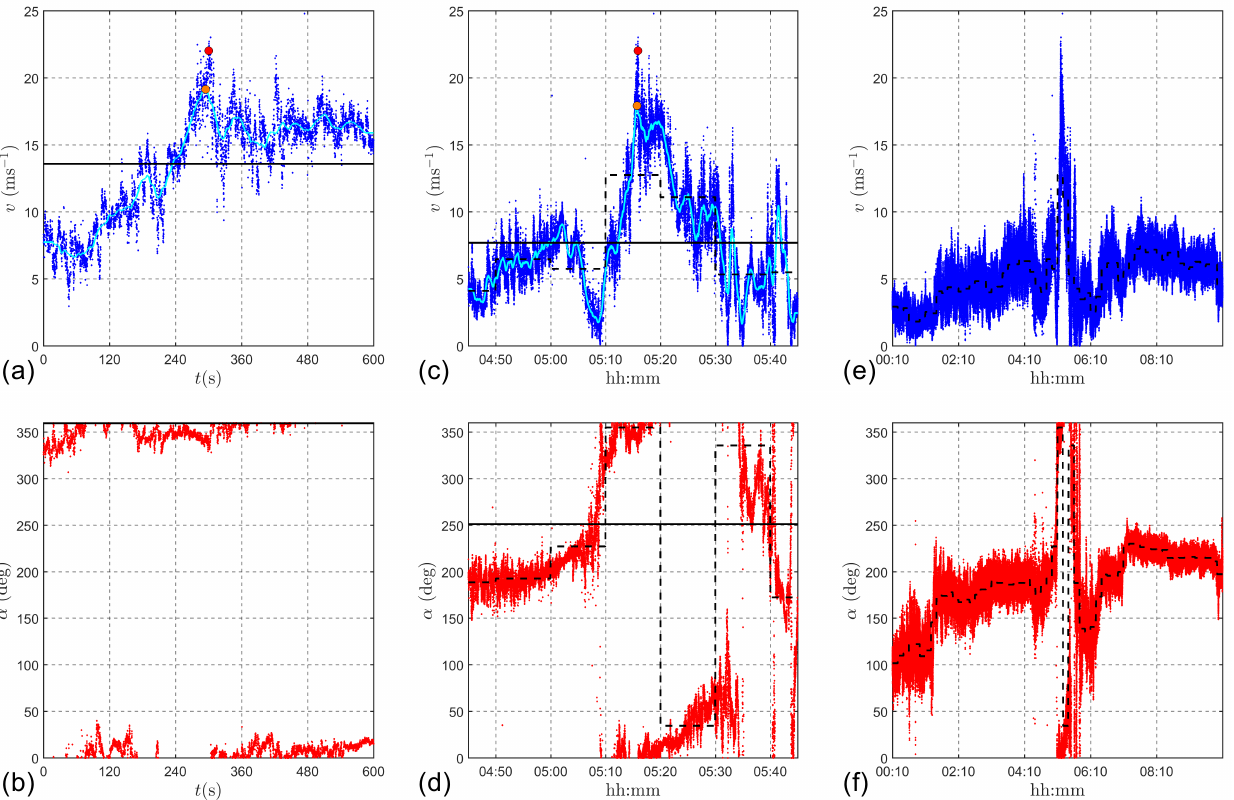
Figure 9. Thunderstorm outflow recorded on 4 October 2015 at about 05:15UTC by the anemometer 1 of the port of Livorno: wind speed time-series in 10min (a) , 1h (c) , and 10h (e) ; wind direction time-series in 10min (b) , 1h (d) , and 10h (f) .